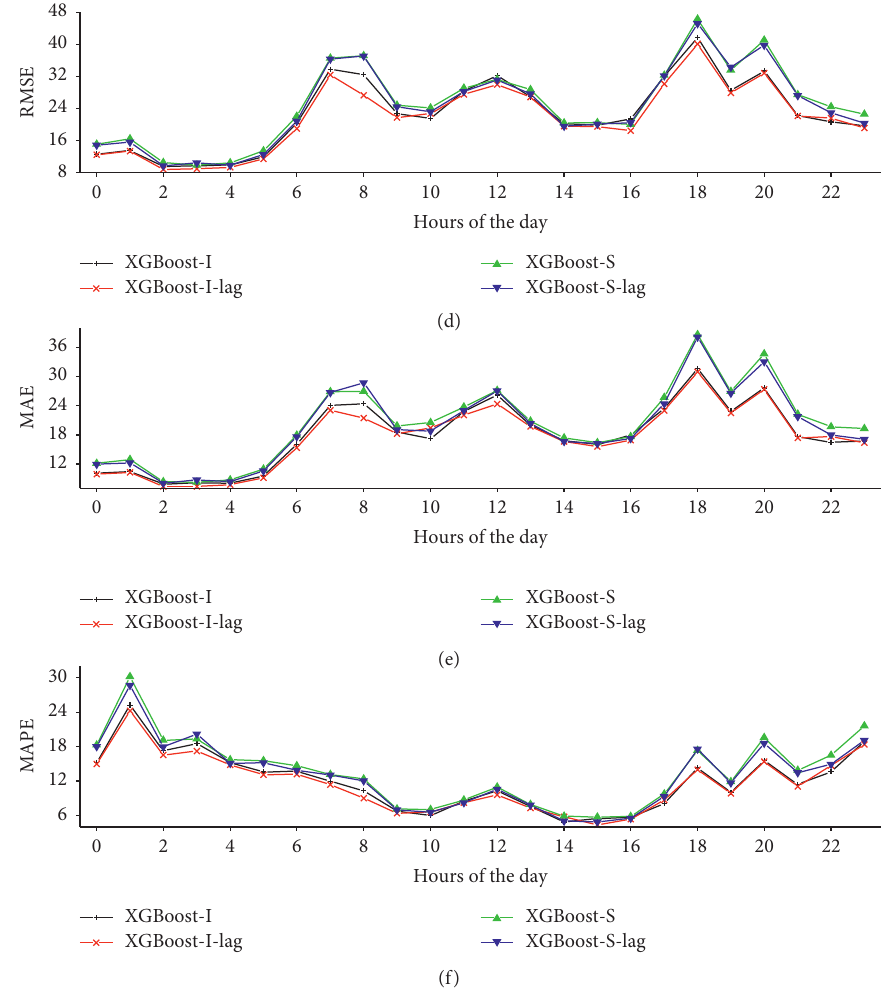
Figure 10: Three errors for the up-direction and down-direction of twenty-four hours’ prediction.